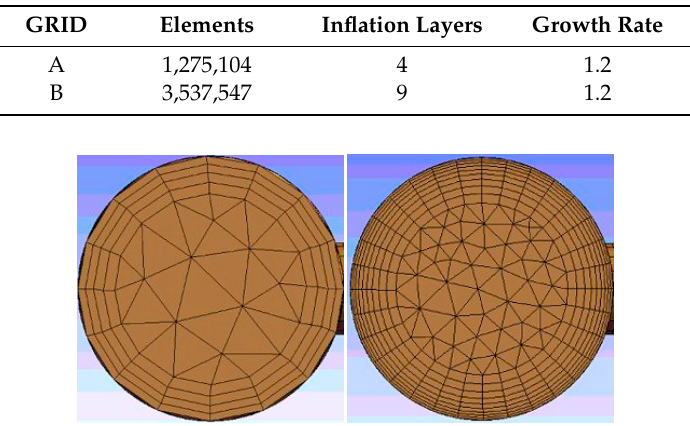
Figure 4. Cross section of a manifold tube for grids A ( left ) and B ( right ).